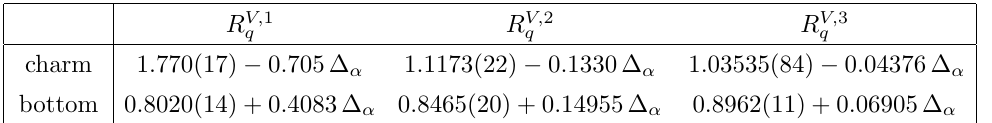
Table 6 . Experimental values for the ratios of moments of the vector-current charm (second row) and bottom (third row) correlator, with (cid:1) (cid:11) (cid:17) (cid:11) ( n f =5) s ( m Z ) (cid:0) 0 : 1181. These quantities are